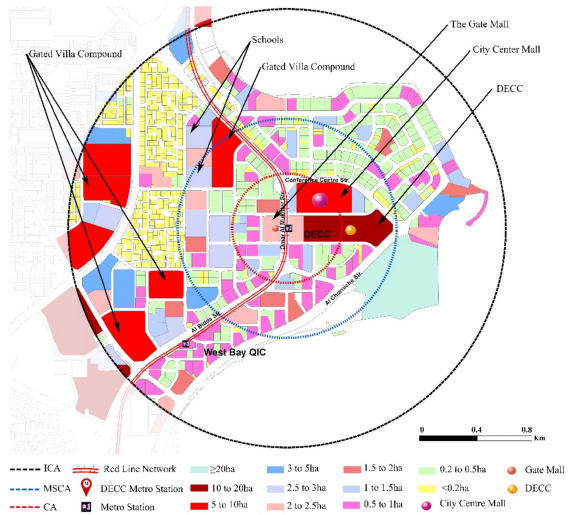
Figure 10. Plot distribution areas within DCA of the DECC metro